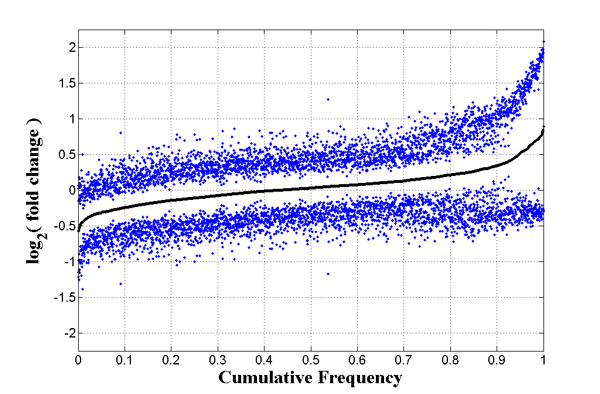
Estimated fold-changes in gene expression of males relative to females for 2800 expressed genes. The black points are the averages of the 9 Loess-smoothed estimates of the logarithm (base 2) of the fold change for the 2,800 expressed genes. The estimates were ordered from smallest to larges and the horizontal axis gives the cumulative proportion. Blue points are upper and lower 95 % confidence bounds.